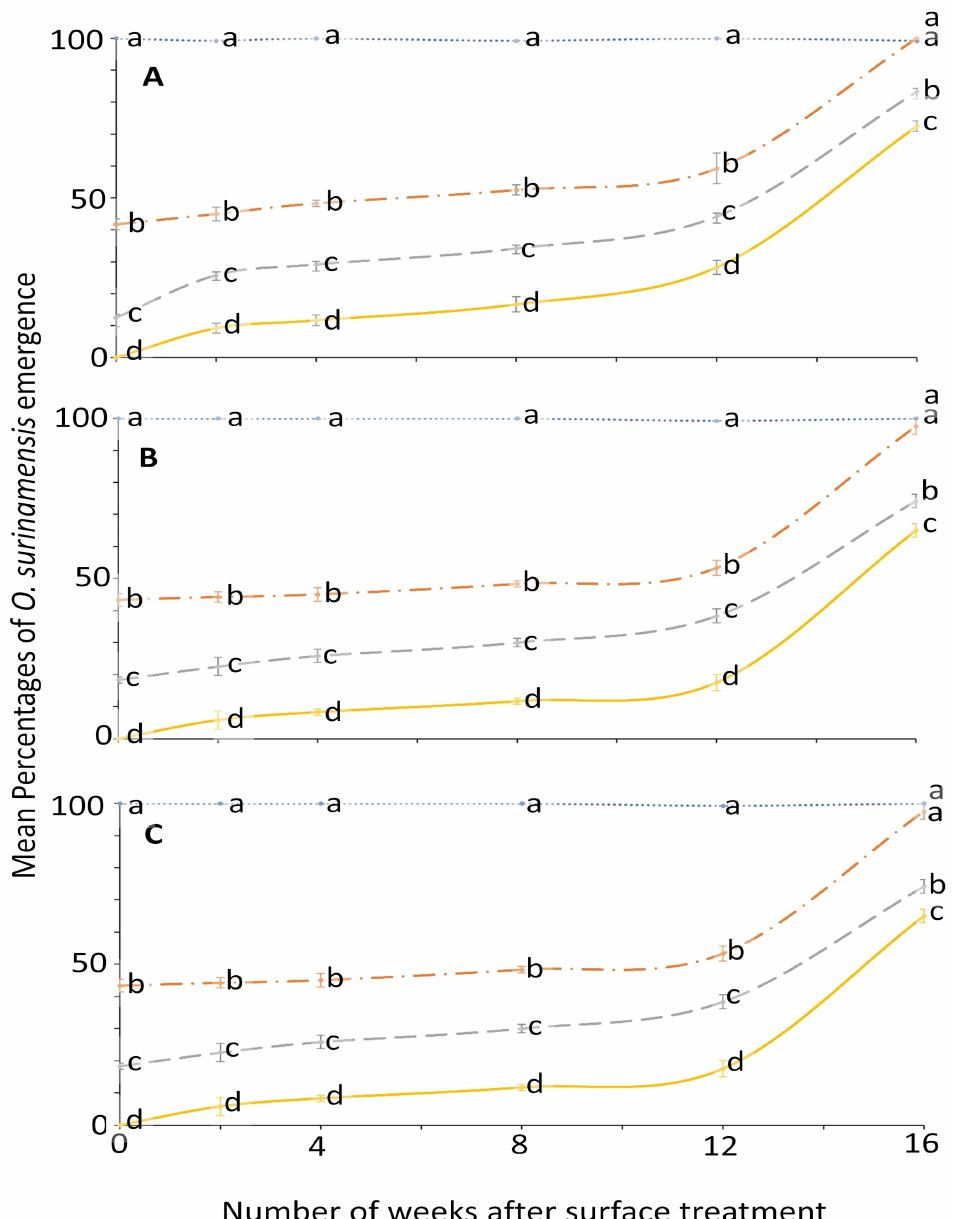
Figure 1. Mean percentages of adults emerging from last-instar O. surinamensis after exposure to novaluron applied 0–16 weeks previously at concentrations of 4- (solid line), 2- (dashed line), 1- (dashed-dotted line), or 0-ppm (dotted line) onto different surfaces: ( A ) concrete; ( B ) metal; or ( C ) wood. In comparisons among mean emergence percentages from different concentrations on a given week after application to a specific surface, designated a–d above, means with the same letter are not significantly different.